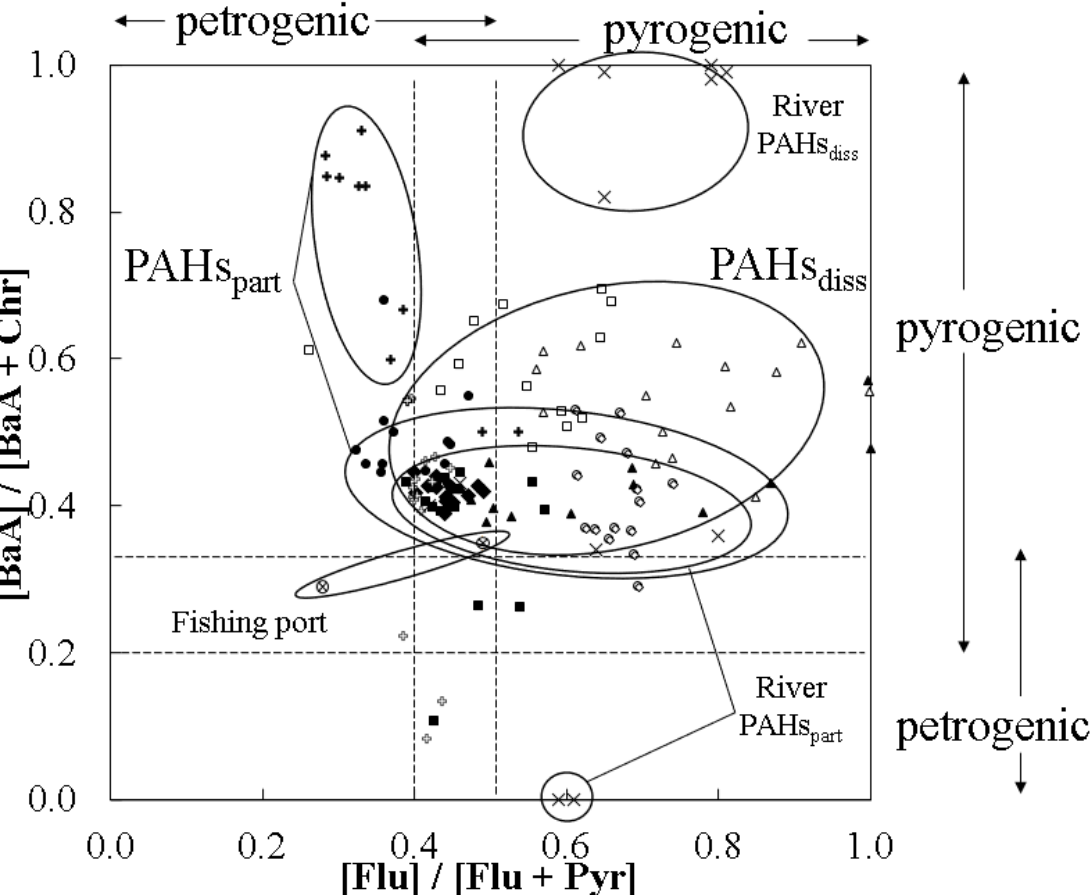
Figure 4. Cross plots of PAH diagnostic ratios: benzo[a]anthracene (BaA) to chrysene (Chr) ([BaA]/[BaA + Chr]) versus fluoranthene (Flu) to pyrene ([Flu]/[Flu + Pyr]). Open and filled symbols represent the values of particulate and dissolved PAHs, respectively. Triangles, squares, circles, diamonds, and crosses represent the data in May 2019, August 2019,